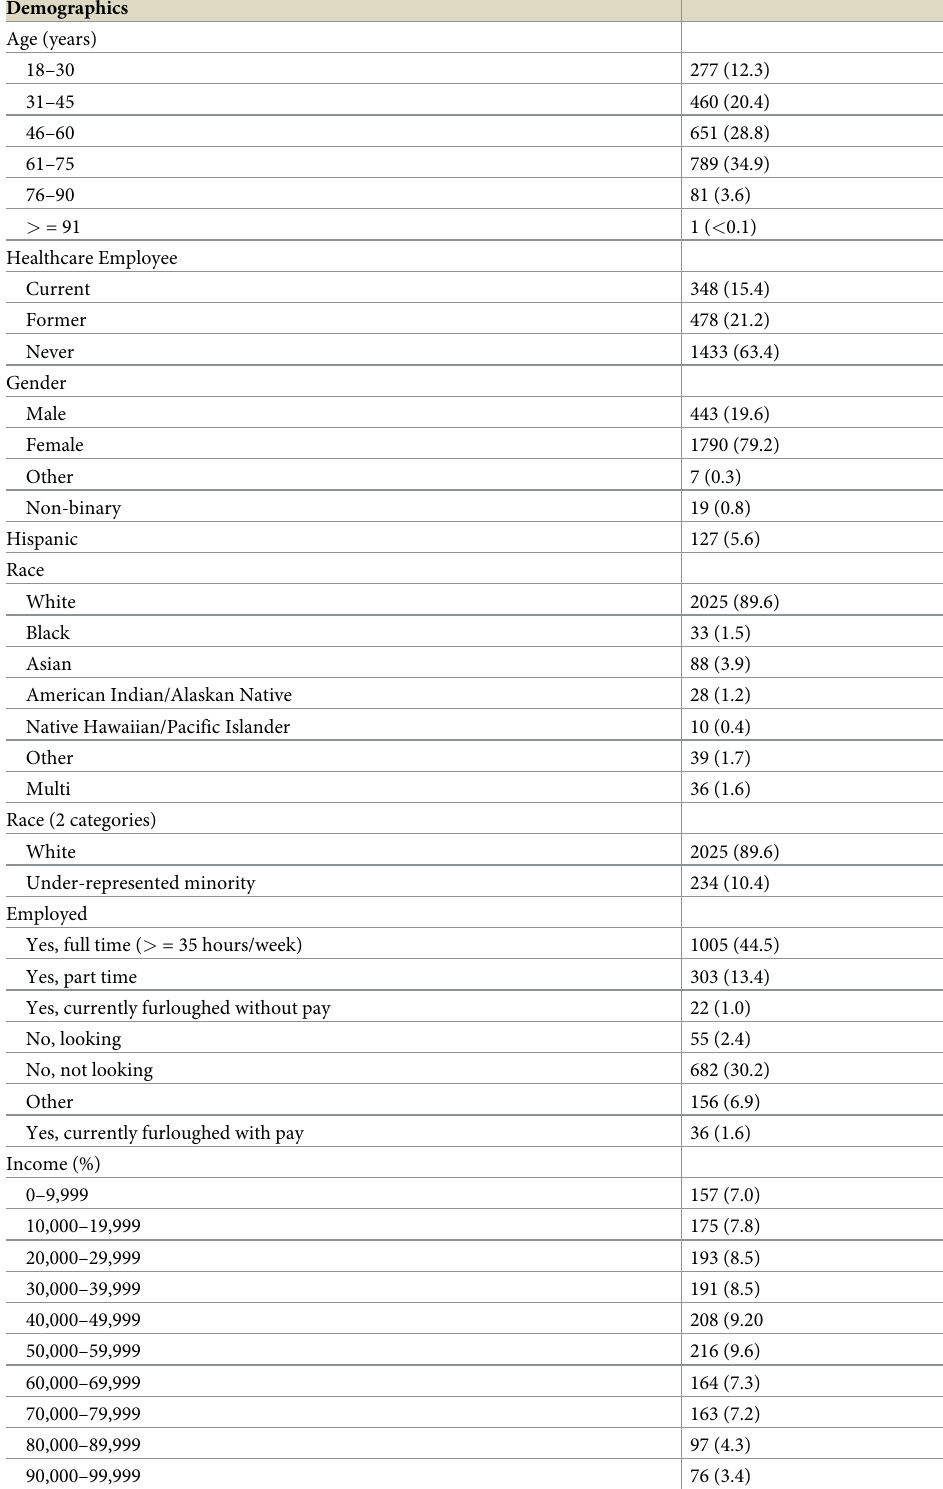
Table 1. Descriptive statistics for variables in